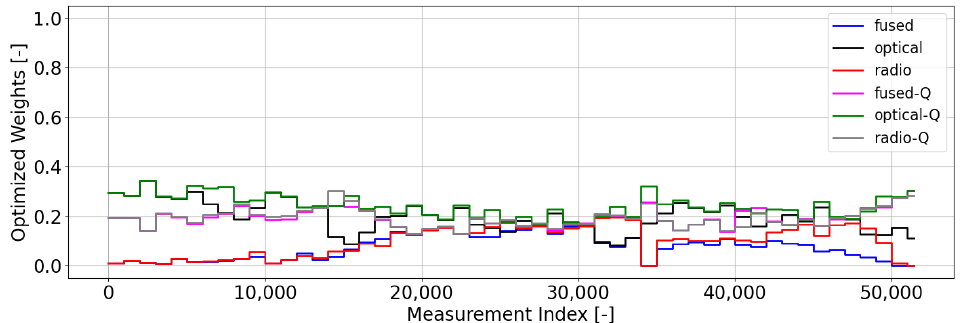
Figure 22. Optimal gating network weights with mis-modeled dynamics and varied process noise